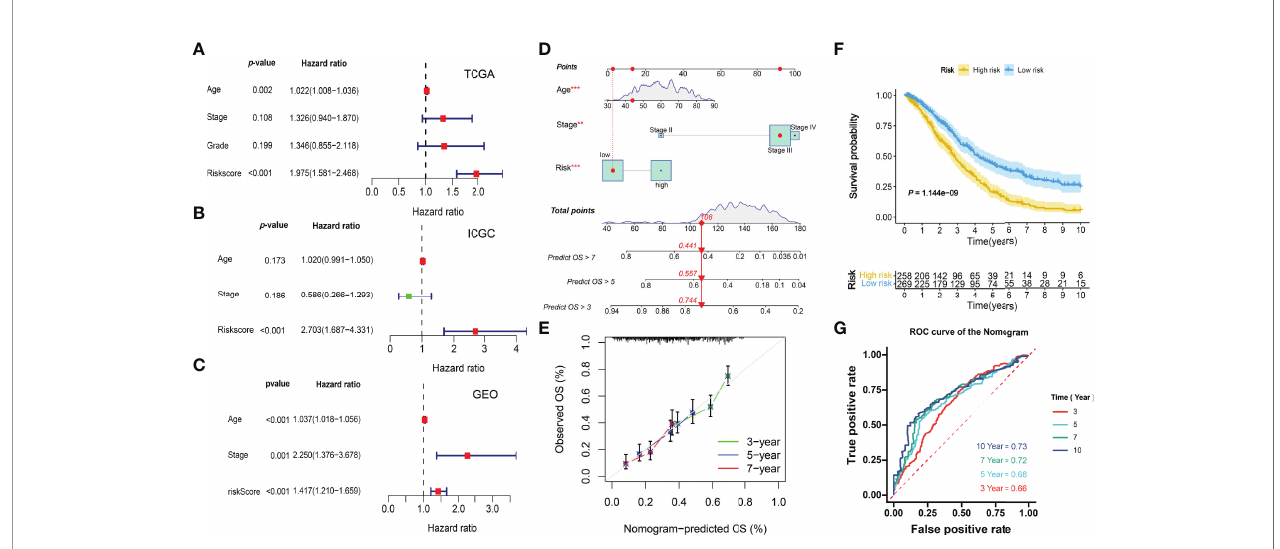
FIGURE 10 | Integration of prognostic nomogram. (A) Multivariate analysis of the TCGA cohort. (B) Multivariate analysis of the ICGC cohort. (C) Multivariate analysis of the GEO cohort. (D) Nomogram predicting 3-, 5-, 7- year overall survival. (E) Calibration curves. (F) Kaplan-Meier curve. (G) ROC curves of the nomogram.